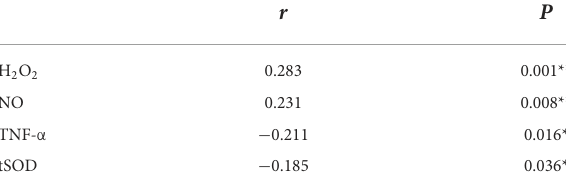
TABLE 4 Correlations of NPI score with the levels of free radicals and neuroinflammatory factors, and the activity of tSOD in CSF from patients with